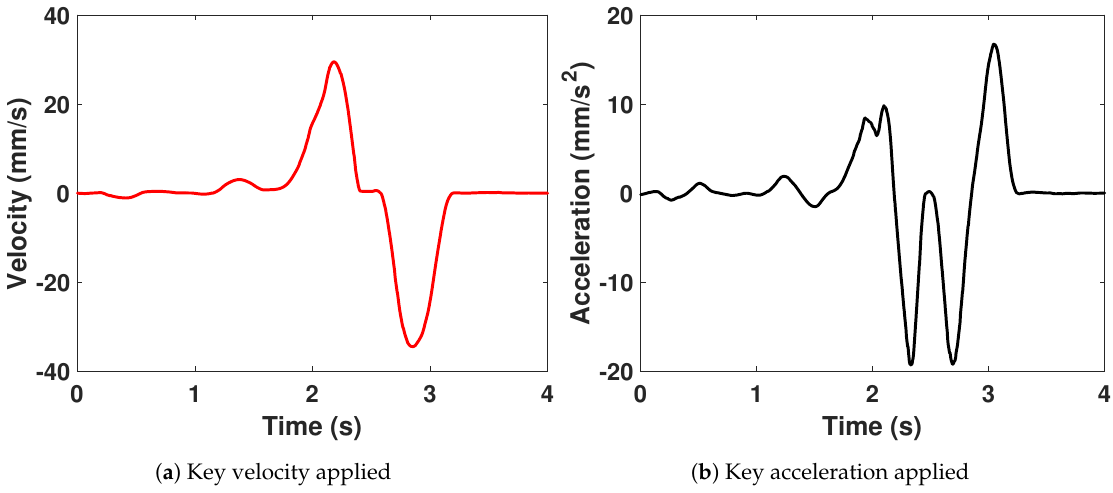
Figure 20. Vertical key velocity and acceleration during the